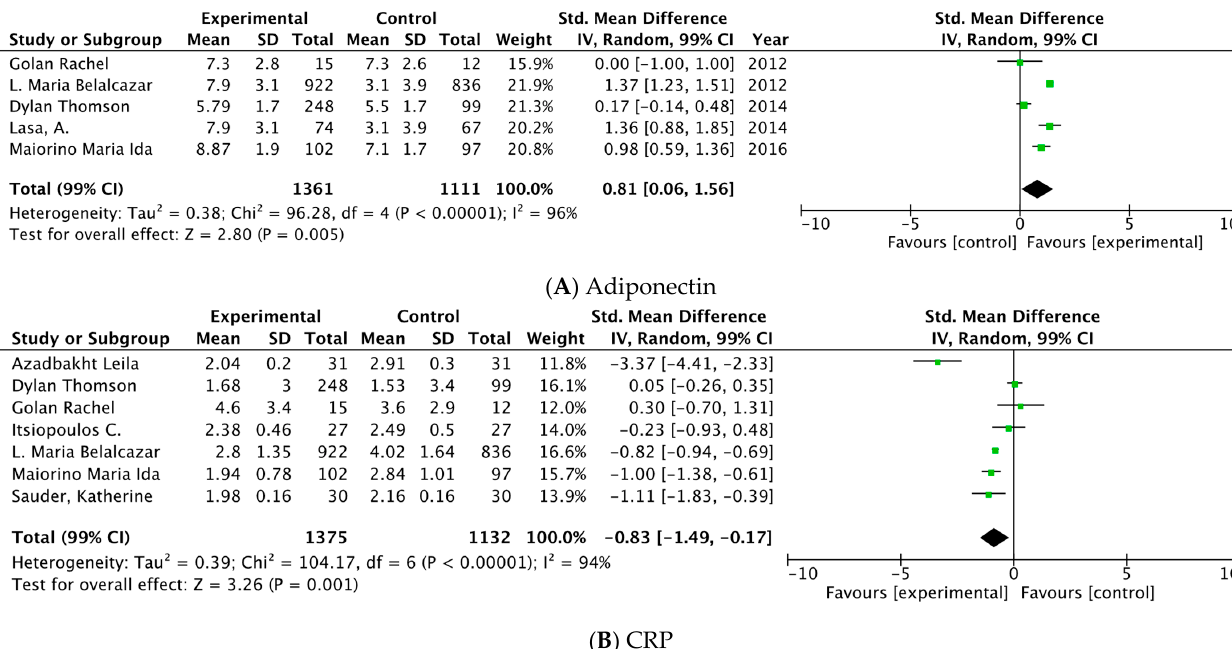
Figure 4. Meta-analysis of intervention studies. Forest plot of comparison between clinical trials presenting SMDS and 99% CI for DPs evaluated. Final values, outcome: ( A ) Adiponectin (ug/mL) with intake of Mediterranean Diet, Diabetes Prevention Program, Diabetes UK healthy eating guide- lines. Outcome: ( B ) CRP (mg/L) with intake of Dietary Approaches to Stop Hypertension, Diabetes UK healthy eating guidelines, Mediterranean Diet, Diabetes Prevention Program, American Heart Association’s Therapeutic Lifestyle Changes diet. Abbreviations: CRP, C-Reactive Protein; WMD, weighted mean